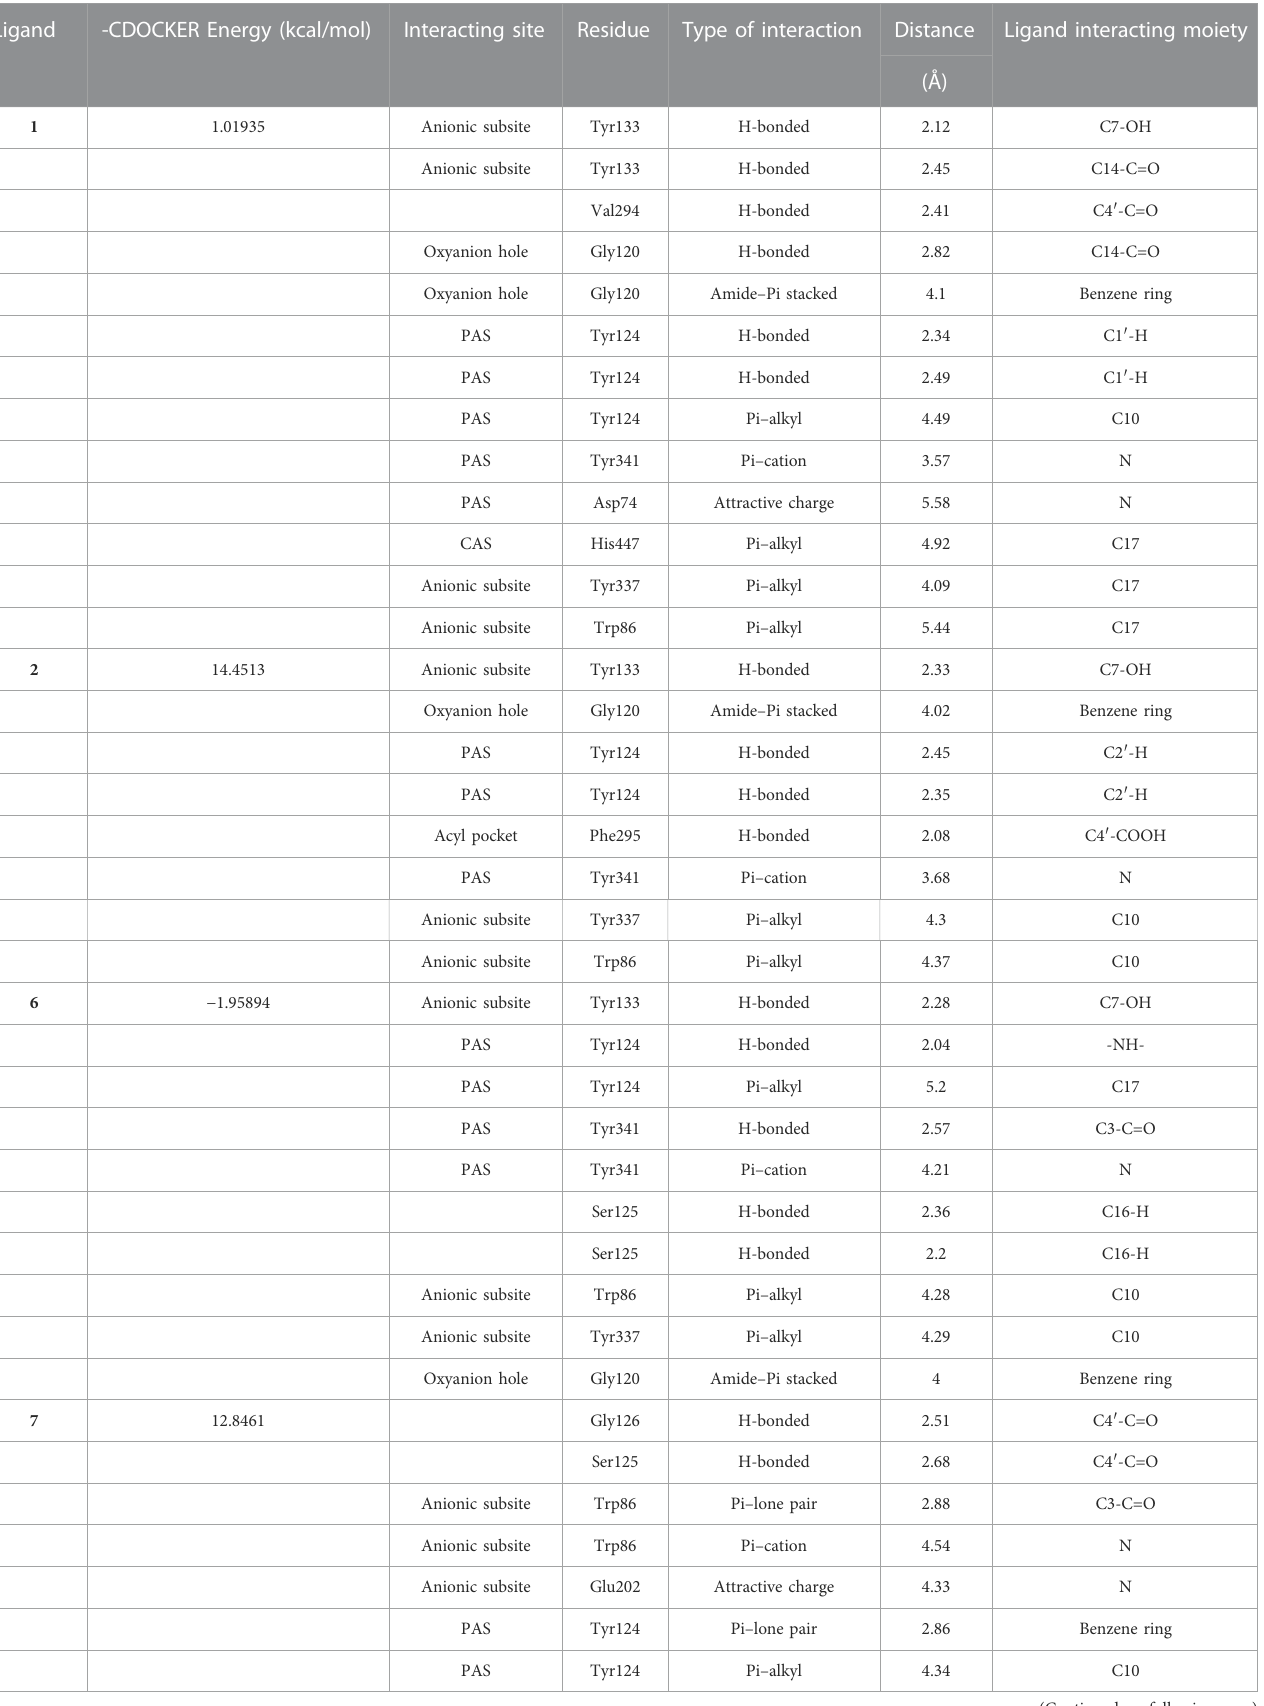
TABLE 4 Binding interaction data of compounds 1 , 2 , and 6 – 8 docked into the active site gorge of AChE.